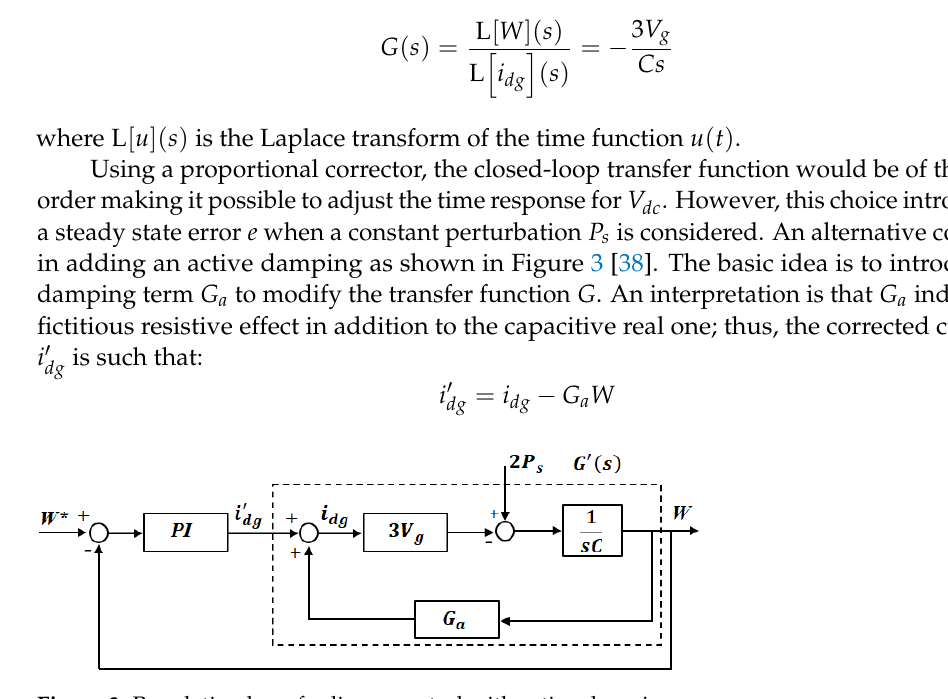
Figure 3. Regulation loop for linear control with active